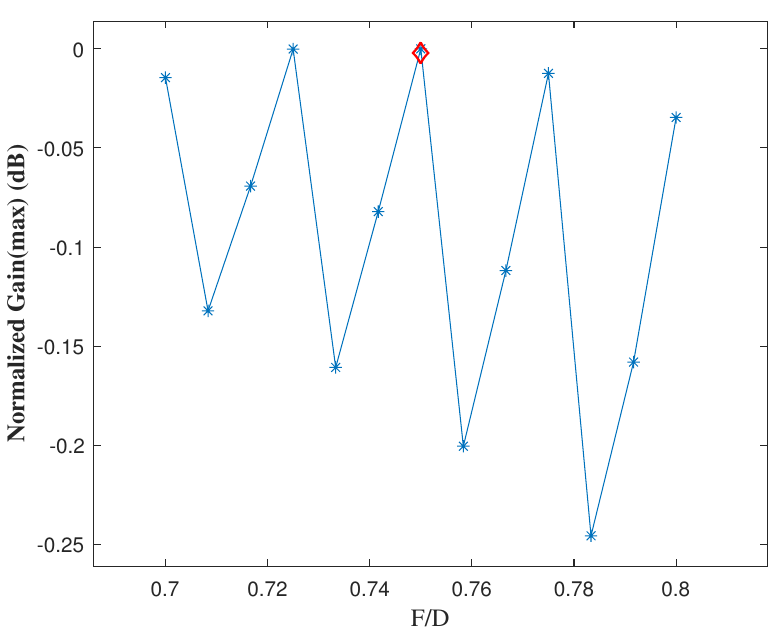
Figure 4. Differences in peak gain of F / D =